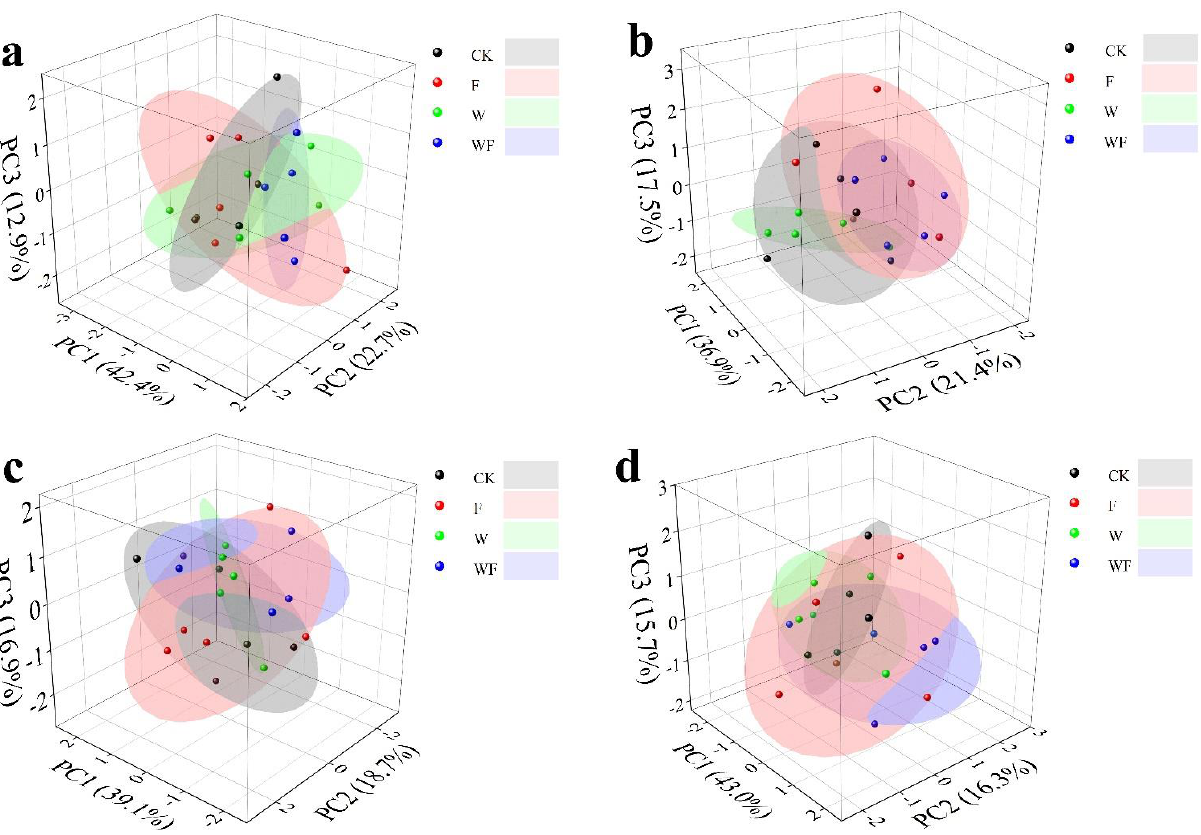
Figure 6. Principal component analysis of TSS ( a ), starch ( b ), NSC ( c ) and ratio of TSS to starch ( d ) under different treatment. The gray, red, green and blue ellipsoids represent CK, F, W and WF treatment, respectively. The data used for PCA were averaged (n = 5).